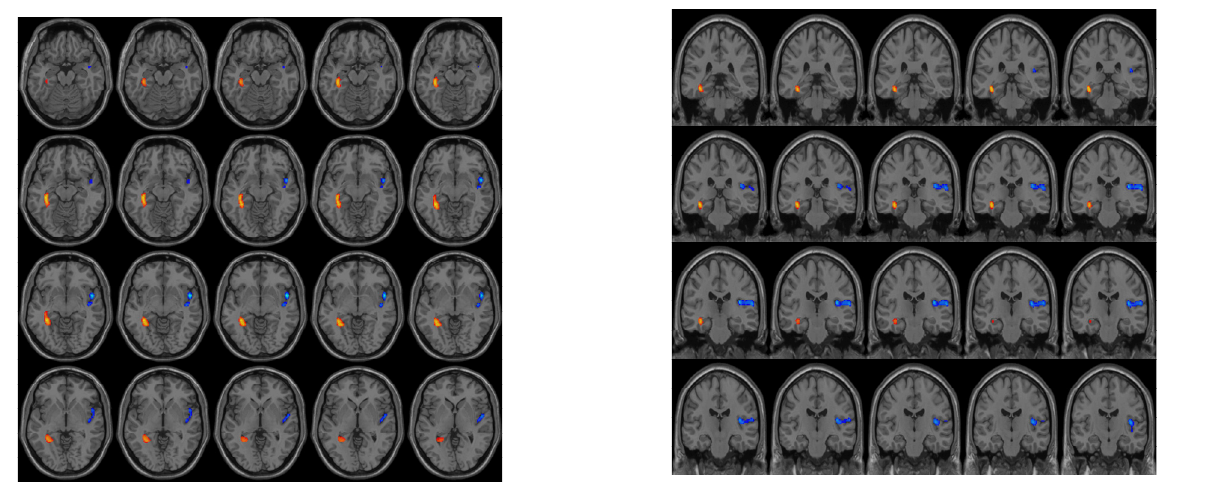
Figure 2. Differences in CBF between the groups. The CKD4 group was found to have decreased CBF in the right insula and increased CBF in the left hippocampus compared to the HC group. No brain regions were found to have significant CBF differences between the CKD3 and CKD4 groups or between the CKD3 and HC groups.